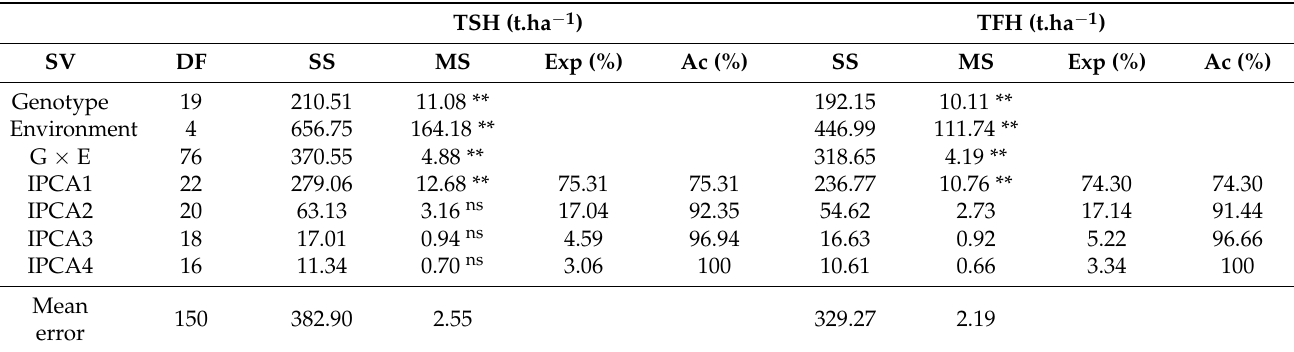
Table 7. Summary of the AMMI analysis of the traits tons of sucrose per hectare (TSH) and tons of fiber per hectare (TFH) in 20 sugarcane genotypes evaluated in five sugarcane microregions in the state of Pernambuco.